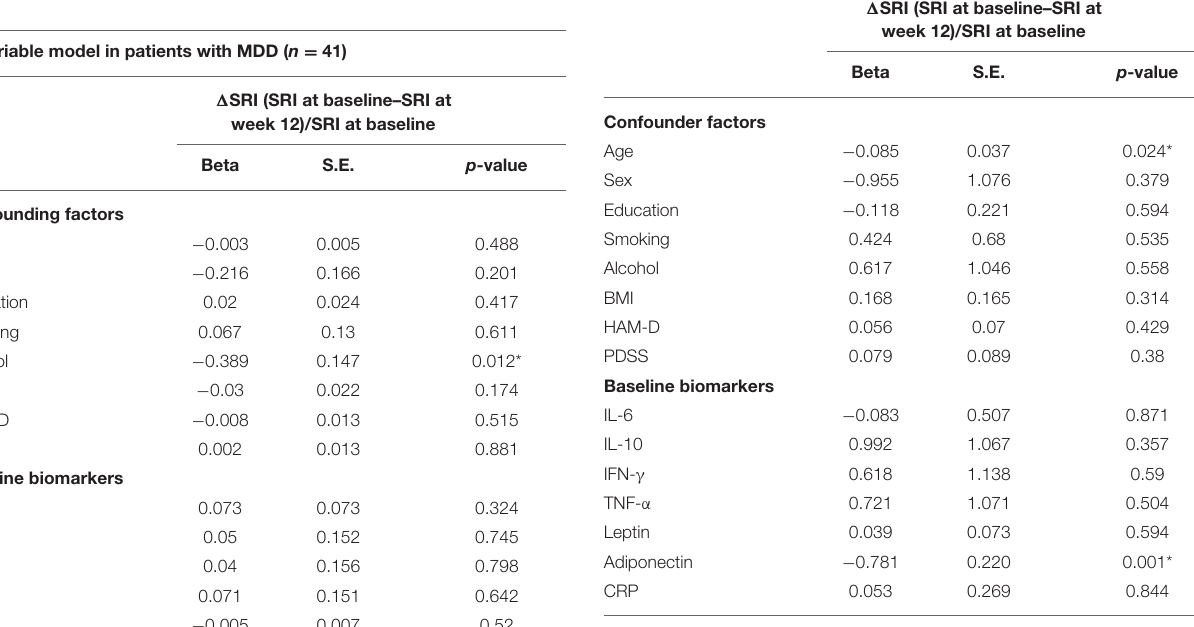
TABLE 3A | Linear regression on predictors of changes in 12-week stress response intensity using baseline inflammatory markers in patients with MDD and PD.